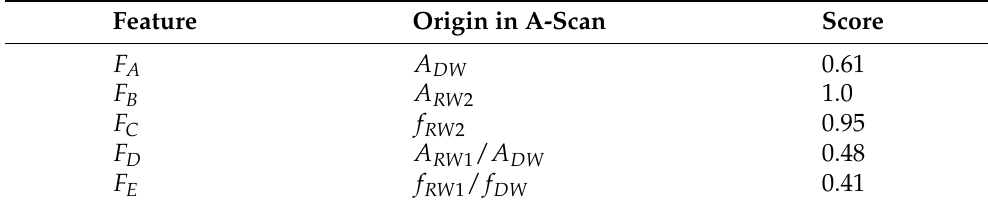
Table 3. Achieved scores of the applied B-scan features.